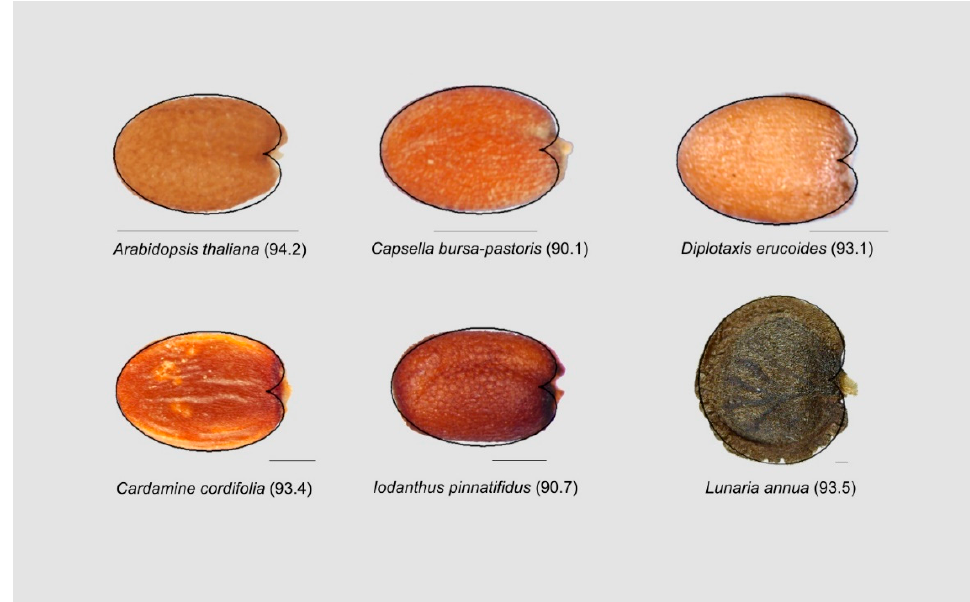
Figure 9. The cardioid and modified cardioid (elongated in the horizontal direction) can be used for seed shape quantification in the Brassicaceae. The values indicated correspond to J index in the images shown and do not represent mean values for each particular species. Bar equals 0.5 mm.